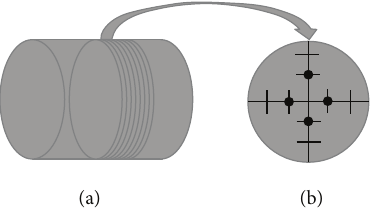
Figure 1: Schematic drawing demonstrating the approach to histo- logical examinations: (a) 8 cross sections were obtained perpendicu- lar to the long axis in the middle; (b) 4 microphotographs of interest in the inner 1/3 radius at 3, 6, 9, and 12 o’clock at 400x magnification were evaluated for MVD (dark black points).